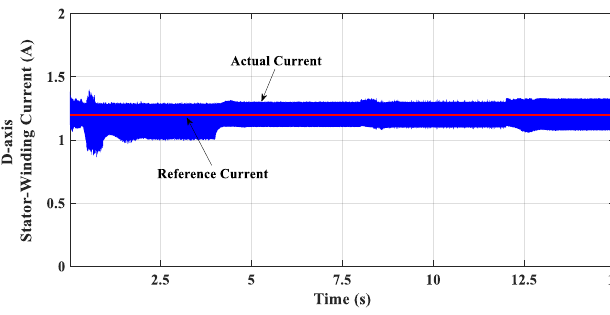
Figure 12. Stator current d-axis component.